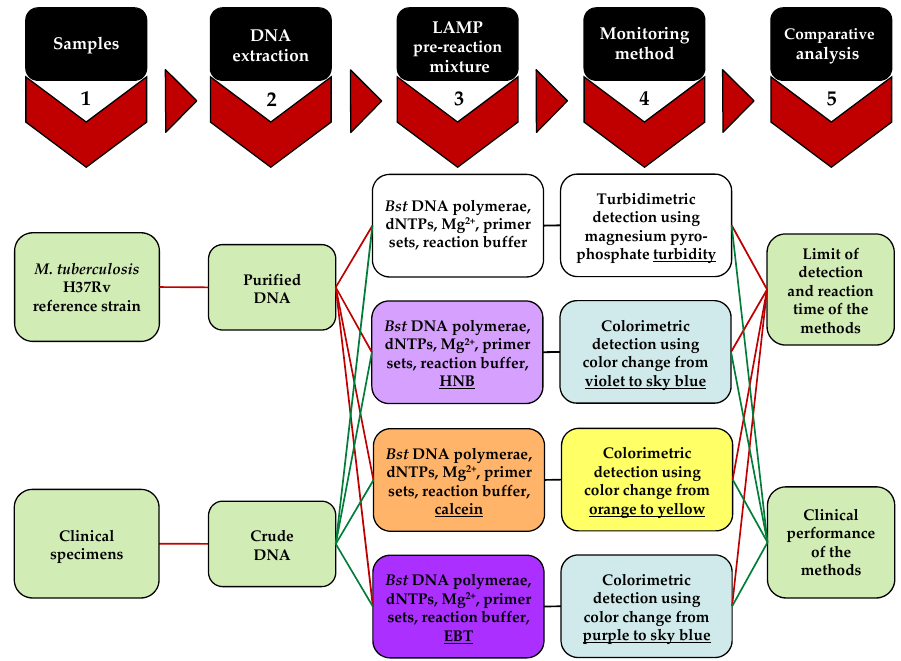
Figure 1. Flowchart representing the experimental approach including stages and methods utilized for comparative closed tube TB-LAMP using the four naked eye methodology for amplification detection. LAMP: loop-mediated isothermal amplification; HNB: hydroxy naphthol blue; EBT: eriochrome black T.